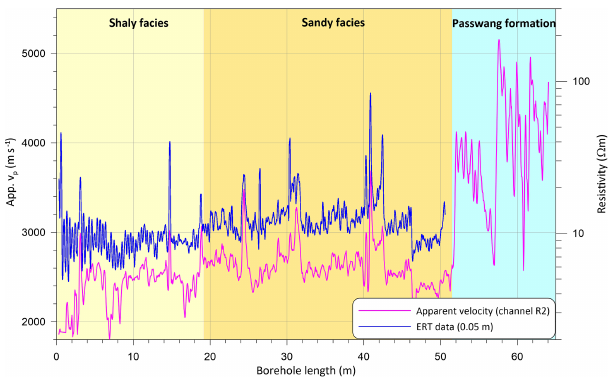
Figure 5. Results from pre-excavation explorations: Apparent velocities (channel R2) and electrical resistivity distribution measured along borehole